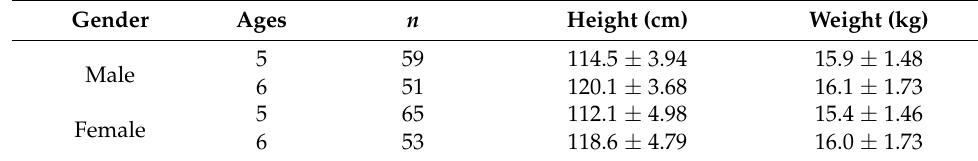
Figure 1. The process of recruiting participants. Table 1. Characteristics of